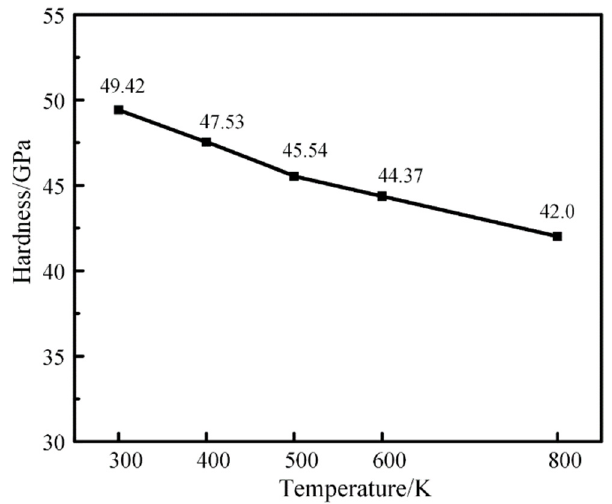
Figure 10. Nanoindentation hardness of M50 bearing steel model measured at different tempera- tures.